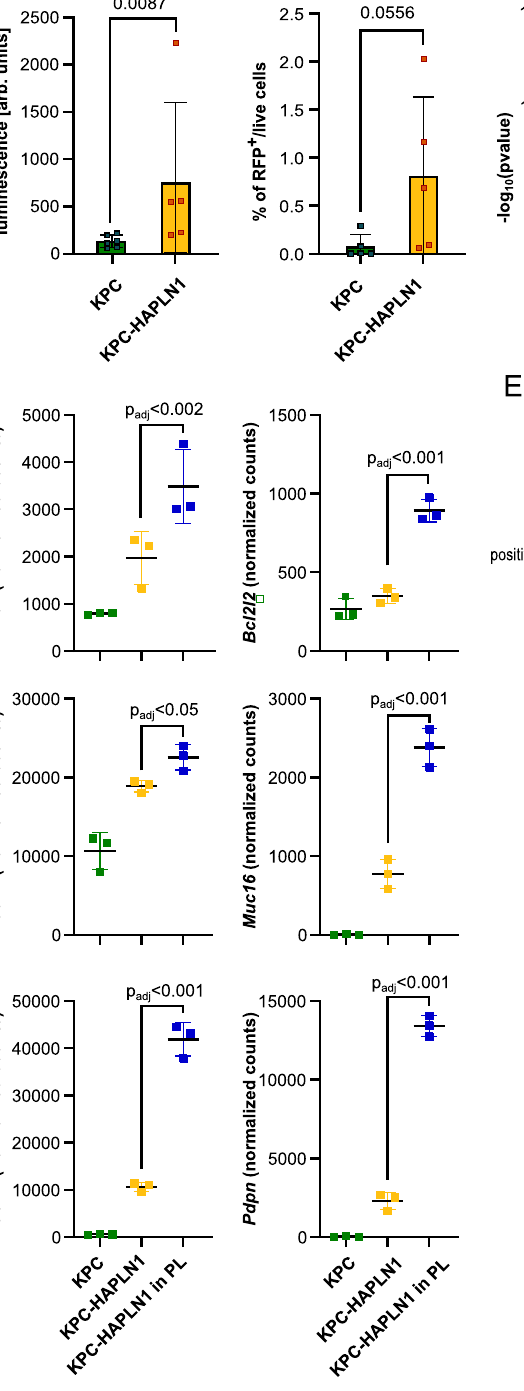
which detached into the peritoneal cavity. F GSEA on the PDAC patient data set of Cao et al. (2021), divided in high or low HAPLN1 expression by the mean HAPLN1 expression. A gene set for genes upregulated in gastric cancer (GC) peritoneal metastasis was used. n =140. Graphs represent mean±SD. Data points indicate independentbiologicalreplicates.Non-parametrictwo-tailedMann – Whitney U test was used for panel A and B . For panels C – E , the package DESeq2 in R studio was used.In this package, the Wald testis used for hypothesistesting whencomparing two groups. Correction was performed by multiple testing using